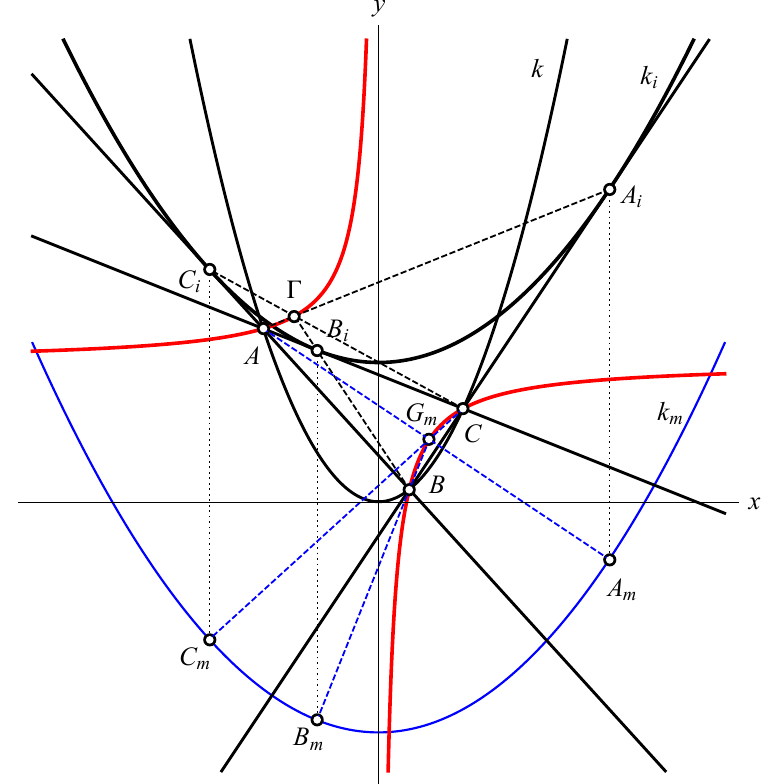
Figure 1. The locus of generalized Gergonne points of the triangle ABC